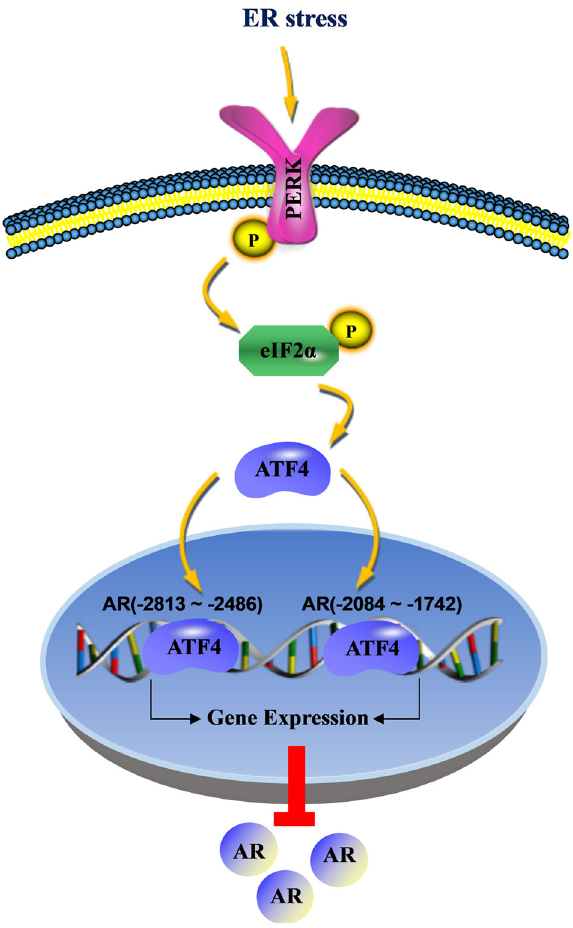
Fig. 9 A proposed model for ER-stress-induced AR decrease. ER- stress activates PERK/ATF4 signaling pathway, then nuclear tran- scription factor ATF4 binds to the AR promoter region to inhibit AR promoter activity, resulting in suppression of AR expression. Endoplasmic reticulum is abbreviated as